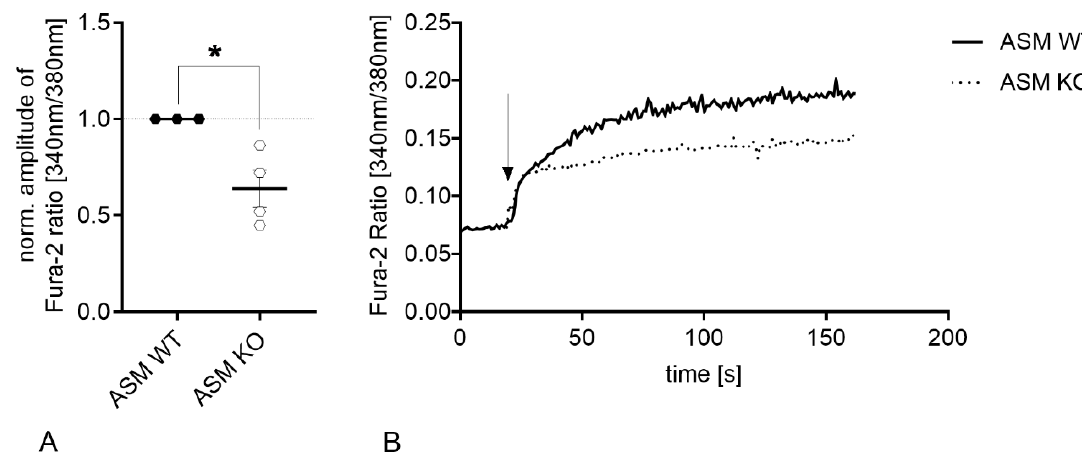
Figure 5. Co-culturing of ASM WT glial cells with ASM KO neurons does not rescue TRPC6 phenotype. ( A ). Ca 2 + influx is reduced in ASM-deficient cortical mouse neurons, which were grown together with ASM WT glial cells compared with ASM WT neurons, which were grown with ASM WT glial cells in a Banker’s culture. ( B ). Representative time-curve of TRPC6-mediated Ca 2 + influx in cortical mouse neurons, which were grown in a Banker’s culture with ASM WT glial cells. Arrow indicates the application of hyperforin 10 µ M. Bars indicate mean ± SEM; n = 3 cell batches, 1–2 cover slips per batch were analyzed; * p ≤ 0.05.